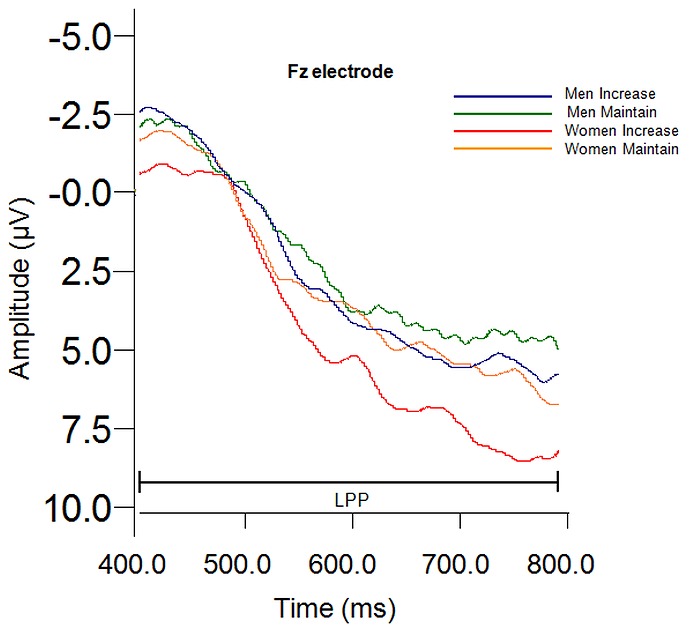
Instruction×Site×Sex interaction for mean LPP amplitude to the “increase” instructional set.